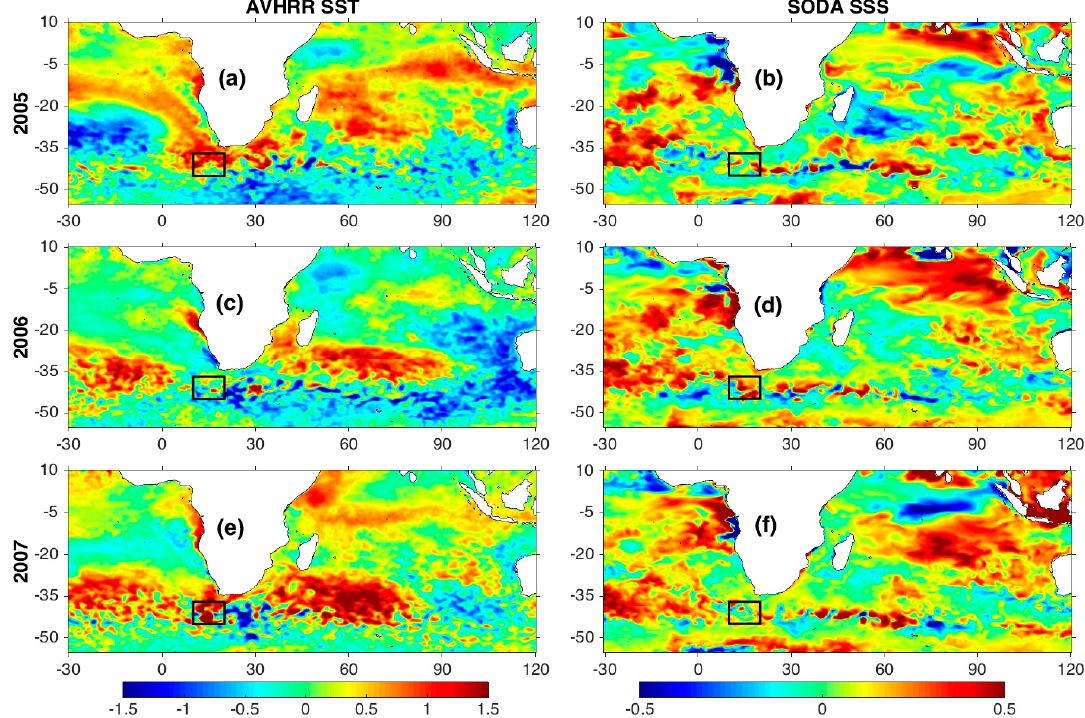
Figure 7. Same as Figure 4 except in reference to the weak 2004–2005 El Niño event during the peak ( a , b ), the following year ( c , d ), and two years after ( e , f ).